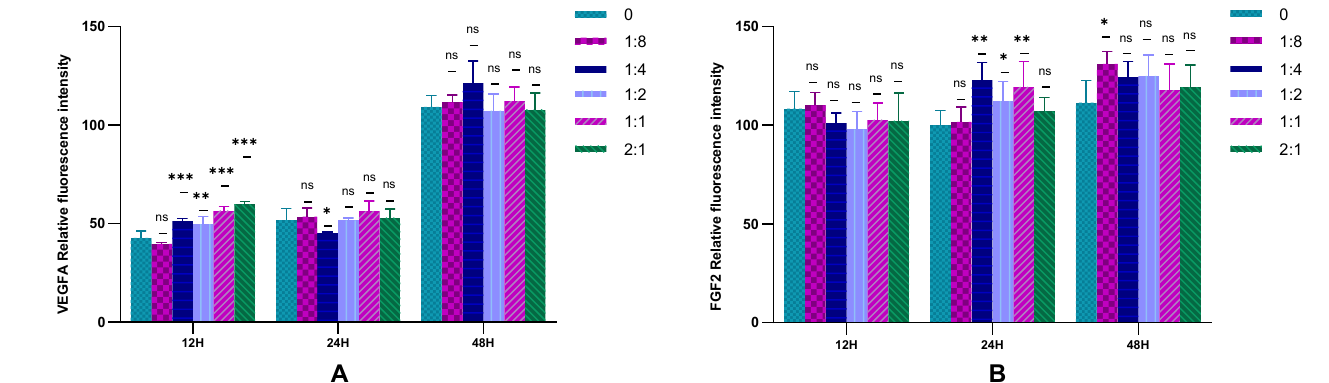
Figure 8. Immunofluorescence statistical map of HSFs in cell co-culture system. ( A ) VEGFA protein and ( B ) FGF2 protein. ns: p > 0.05, *: p < 0.05, **: p < 0.01, ***: p < 0.001.